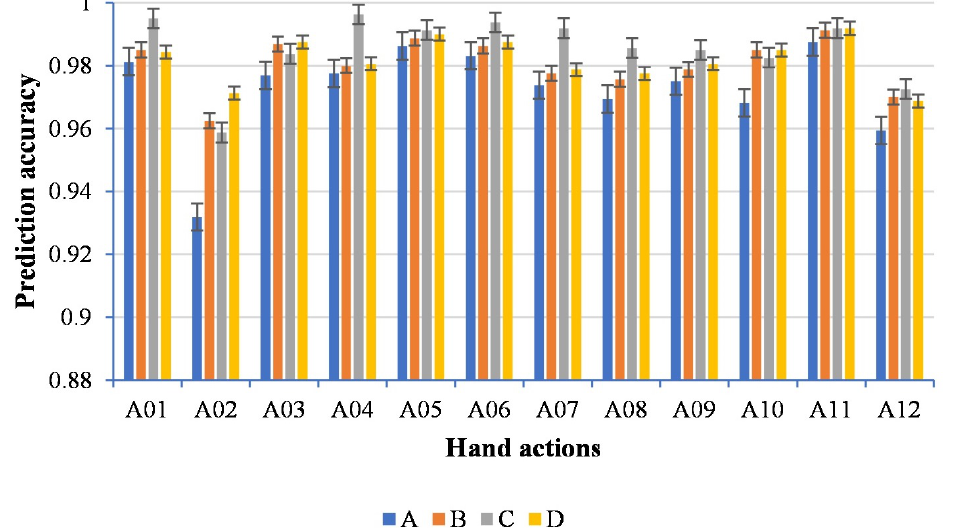
Figure 5. Prediction accuracy for four different settings of the sliding window. A represents a length of 10 frames with an increment of 10 frames; B represents a length of 20 frames with an increment of 20 frames; C represents a length of 25 frames with an increment of 25 frames; D represents a length of 30 frames with an increment of 30